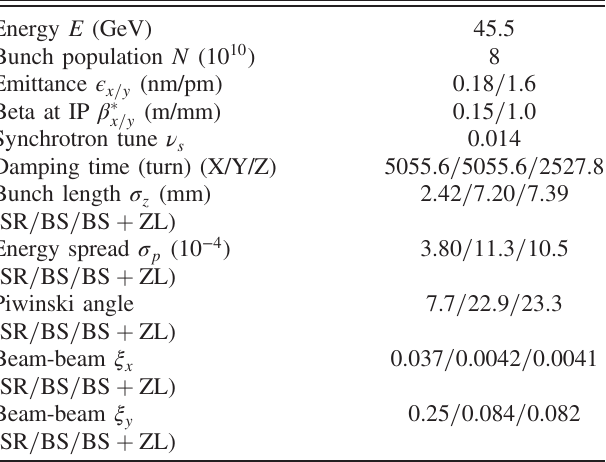
TABLE I. Machine parameters a .